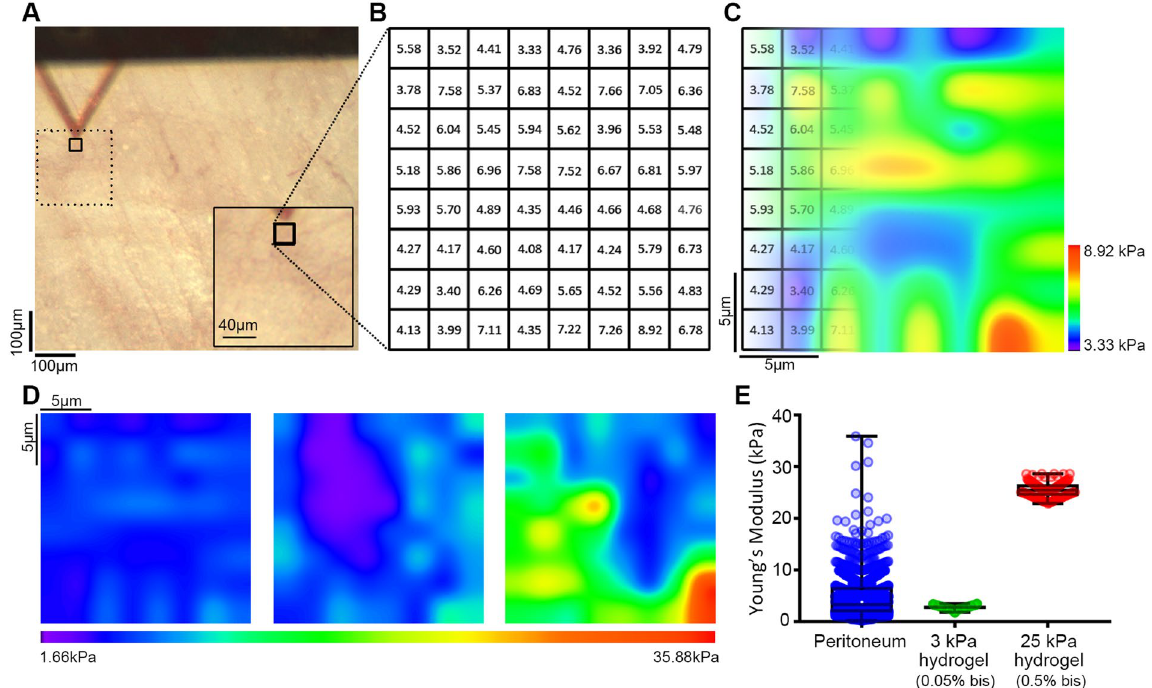
Figure 1. Assessment of peritoneal rigidity by atomic force microscopy. ( A ) Mouse peritoneum was mounted on an atomic force microscope (AFM) and force-indentation curves were obtained using a 5 μ m spherical probe mounted on a cantilever (triangle). ( B ) Force-maps were generated by obtaining an 8 × 8 grid of Young’s elastic modulus ( E ) values from 20 μ m × 20 μ m regions within a tissue section. ( C and D ) The grids were transformed into color-coded heat maps, the scales of which could be was set using minimum and maximum values from an individual map ( C ) or from values from a series of maps to compare results between numerous regions across several different animals ( D ; note that the leftmost map in ( D ) is the same map, shown with different value scaling, as in ( C )). ( E ) Box and whisker plots showing minimum and maximum (lower and upper whiskers), 25th-75th quartiles (box), and median (horizontal line inside box) E values from normal mouse peritoneum (ms. peritoneum) and soft (3 kPa) or stiff (25 kPa) polyacrylamide hydrogels (0.05% or 0.5% bis-acrylamide crosslinker, respectively; n = 1724 for mouse peritoneum and n = 128 for each